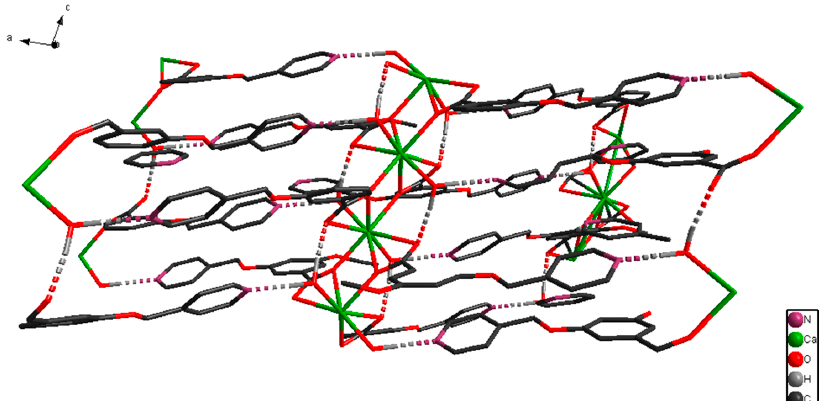
Figure 2. 2D layered structure of [CaL 2 (H 2 O) 2 ] n .